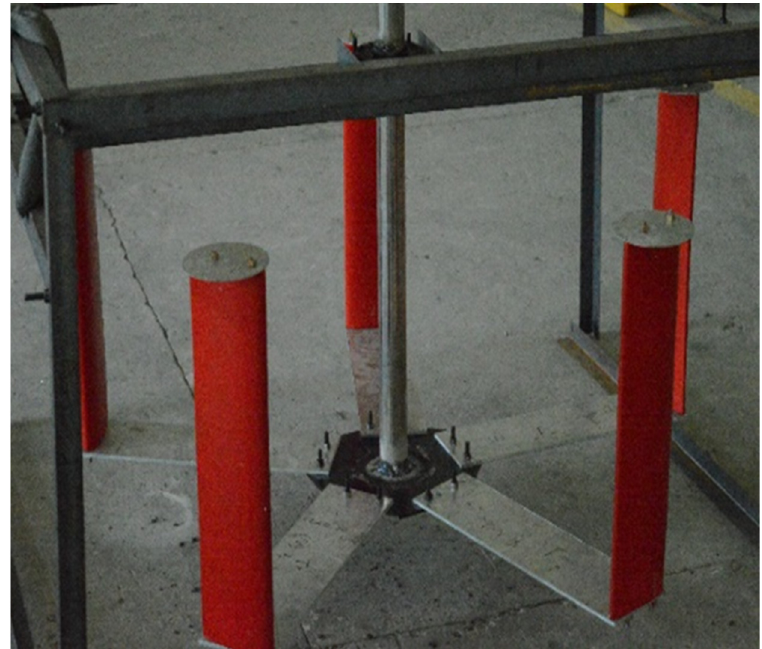
Figure 15. The assembled turbine. Figure 16. The assembled turbine.